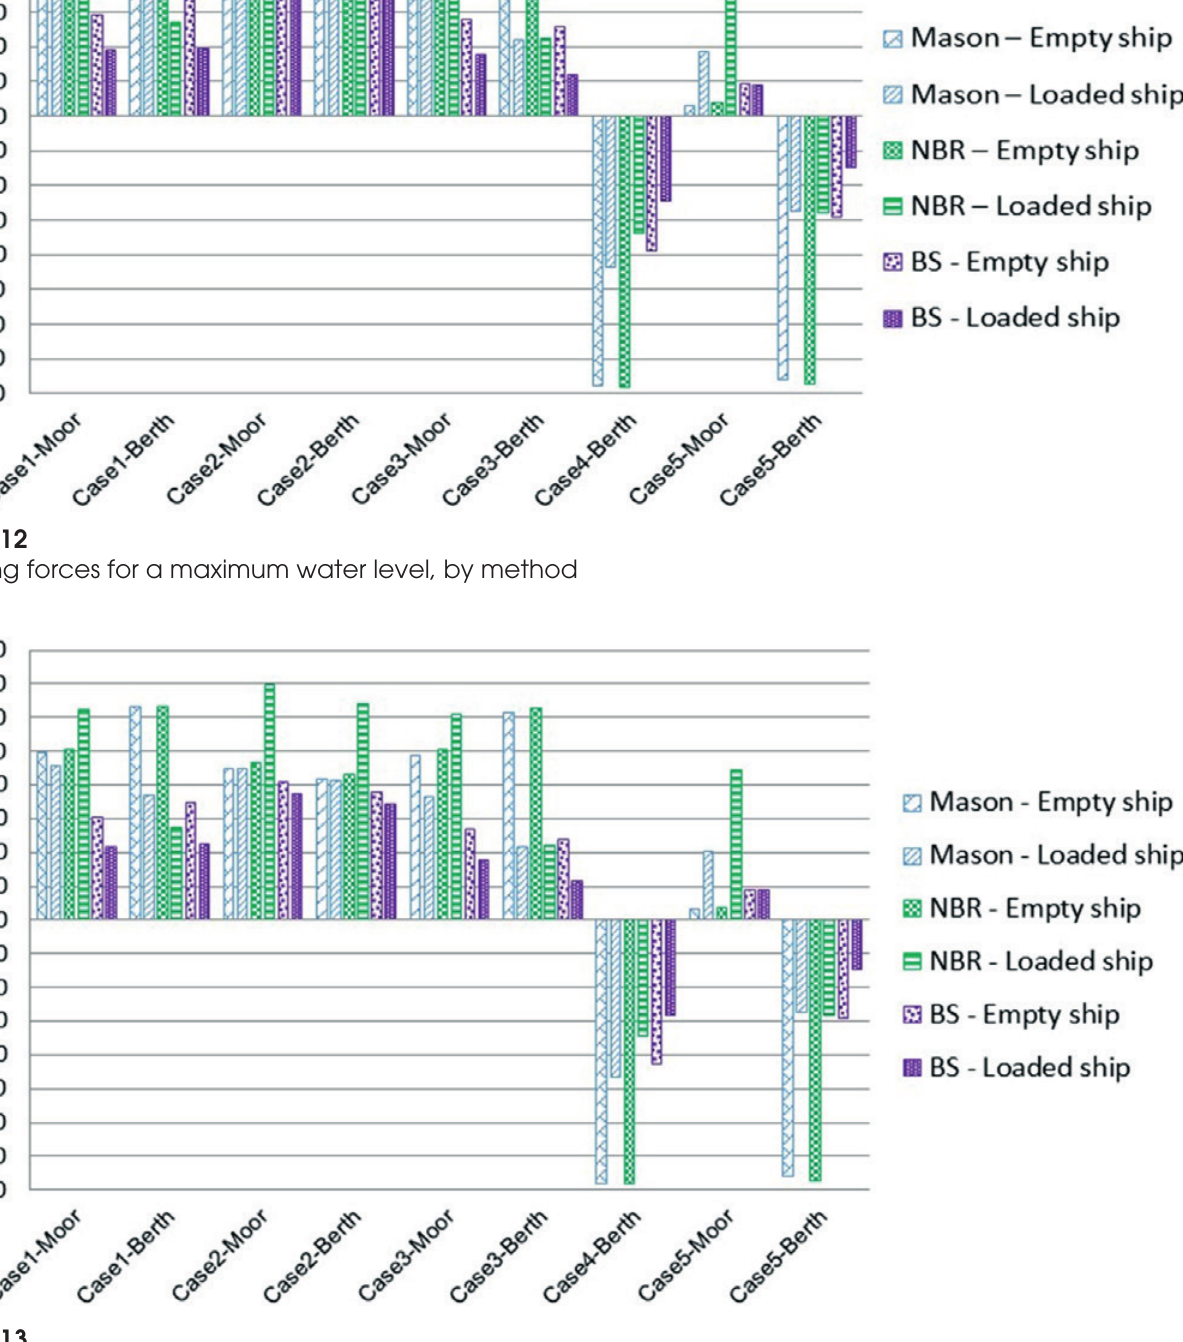
Mooring forces for a minimum water level, by